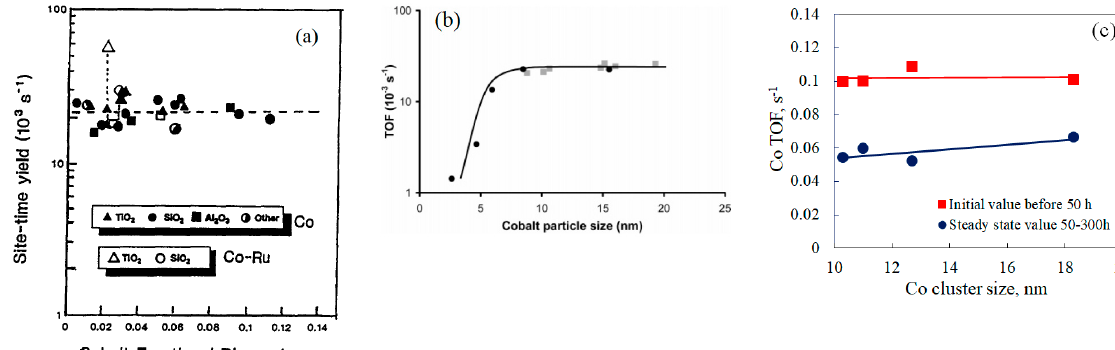
Figure 4. ( a ) Effect of cobalt dispersion (ratio of surface Co to total Co atoms), 200 °C, 2.0 MPa, H 2 /CO = 2.05, 55–65% CO conversion, C 5+ selectivity > 80% (reproduced with permission from [41] Copyright 1997, Elsevier), ( b ) the influence of cobalt particle size on the TOF at 3.5 MPa, 210 °C and H 2 /CO = 2.0 (reproduced with permission from [44] Copyright 2006, Elsevier), ( c ) the influence of cobalt particle size on Co TOF at 2.2 MPa, 220 °C and H 2 /CO = 2.1 (data from [48]).